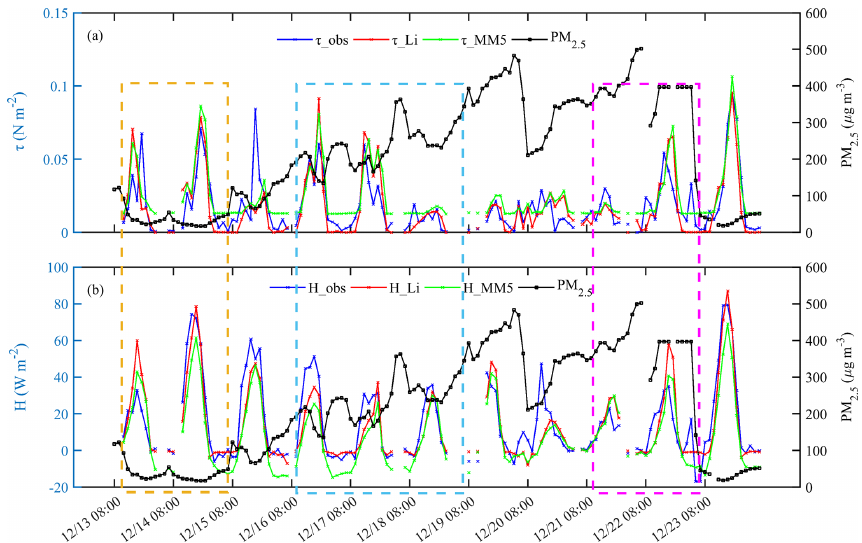
Figure 7. Variations of hourly turbulent fluxes and observed PM 2 . 5 at Gucheng station in daytime. (a) Momentum fluxes τ (blue line: observations; red line: the Li scheme; green line: the MM5 scheme) and PM 2 . 5 concentration (black line); (b) sensible heat fluxes H (the same as τ ) and PM 2 . 5 concentration (black line). Yellow box: stage 1; blue box: stage 2; purple box: stage